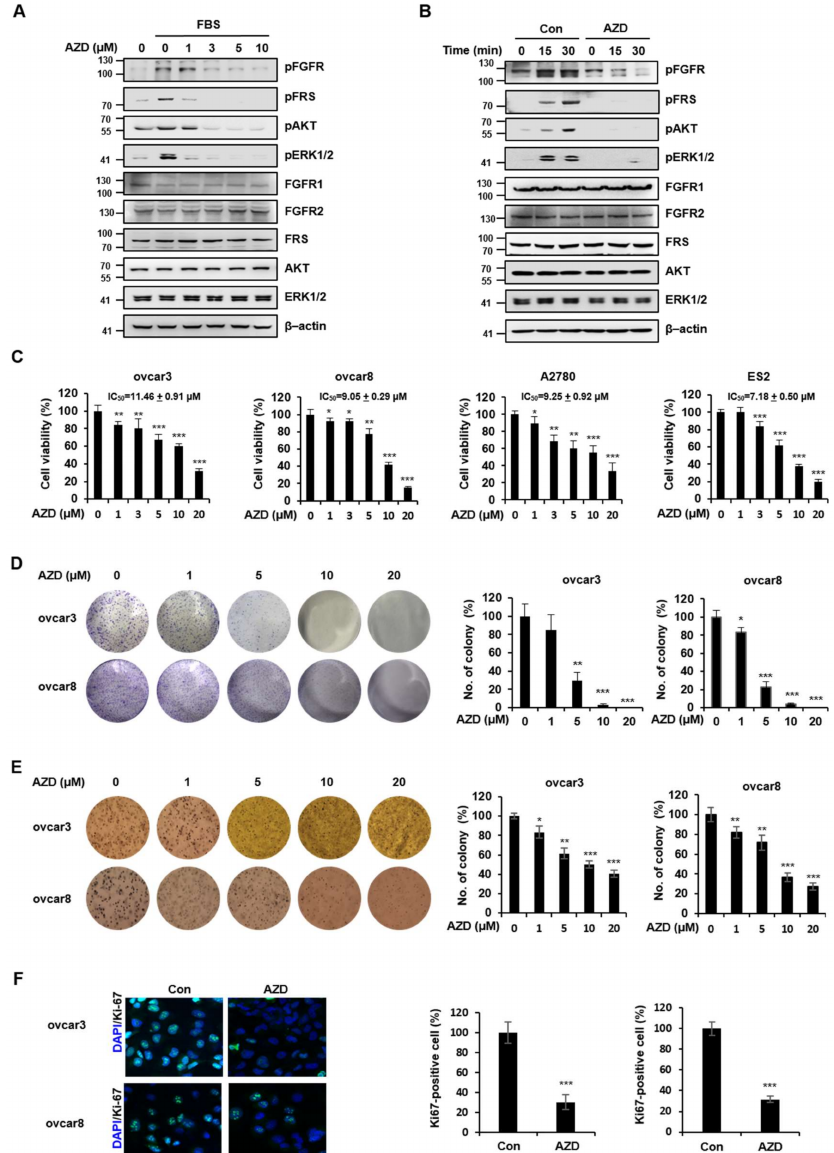
Figure 2. AZD4547 exerts antiproliferative effects in ovarian cancer cells. ( A ) Ovcar3 cells were pretreated with AZD4547 (0, 1, 3, 5, and 10 µ M) for 2 h, followed by fetal bovine serum (FBS) treatment. ( B ) Ovcar8 cells were pretreated with 10 µ M AZD4547 for 2 h, then stimulated by FBS for the indicated times. ( C ) Ovcar3, ovcar8, ES2, and A2780 cells were treated with AZD4547 for 48 h. Cell viability was determined using the CCK-8 assay. ( D ) Ovcar3 and ovcar8 cells were treated with AZD4547 for 1 week. ( E ) Ovcar3 and ovcar8 cells were seeded onto soft agar and treated with AZD4547 for 3 weeks. Left panel, representative images of colony formation. Right panel, quantification of the corresponding colony formation. ( F ) Ovcar3 and ovcar8 cells were treated with 5 µ M AZD4547 for 24 h. Left panel, representative images of DAPI/Ki- 67 immunofluorescence. Right panel, quantification of the corresponding immunofluorescence. FGF, fibroblast growth factor; FGFR, fibroblast growth factor receptor; FRS, fibroblast growth factor receptor substrate; ERK1/2, extracellular signal-regulated kinase 1/2; AZD, AZD4547. * p < 0.05, ** p < 0.01, *** p <